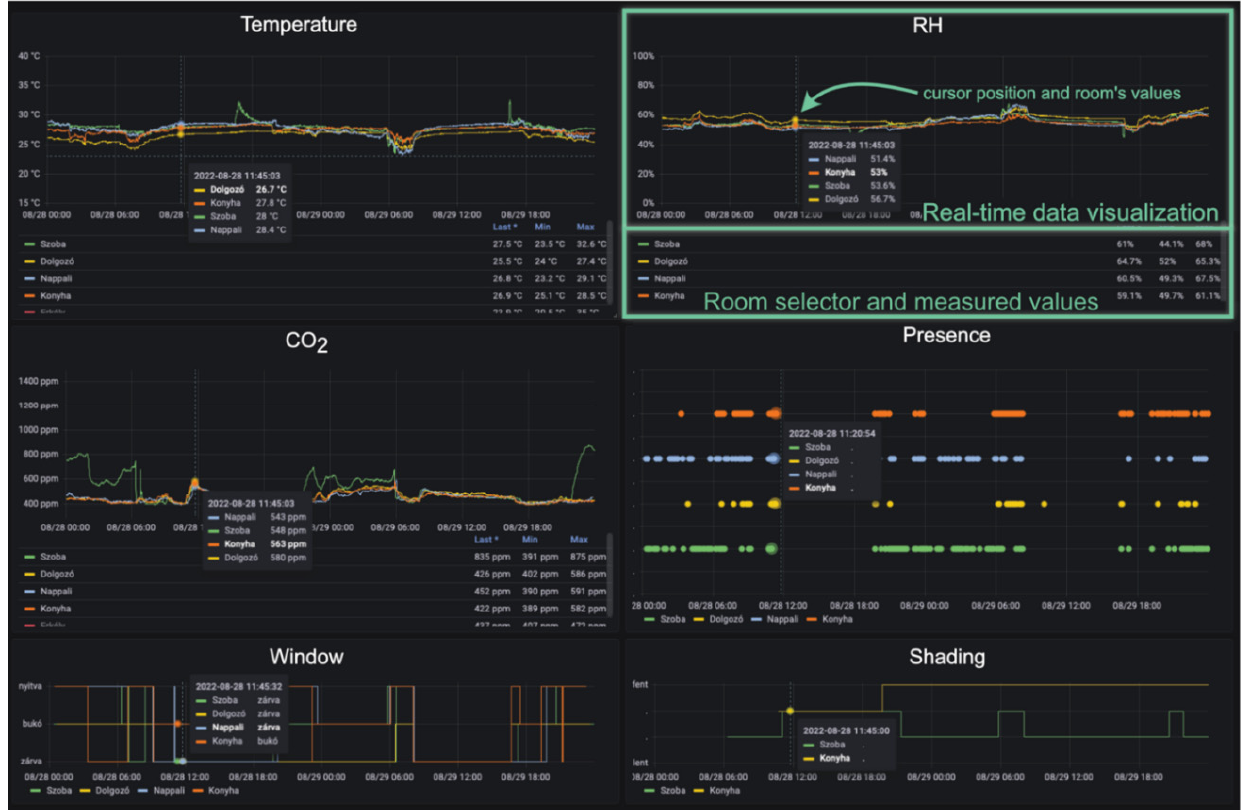
Figure 7. Web application visualisation example.